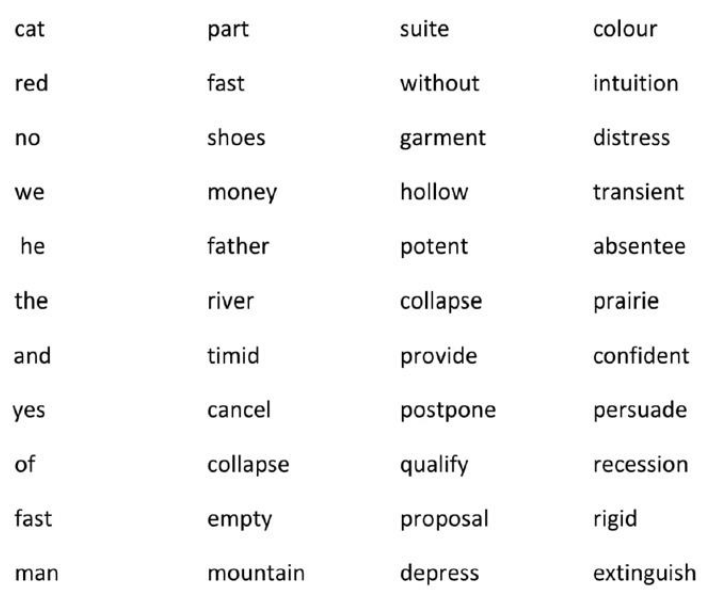
Figure A1. Test of Word Reading Efficiency (TOWRE).